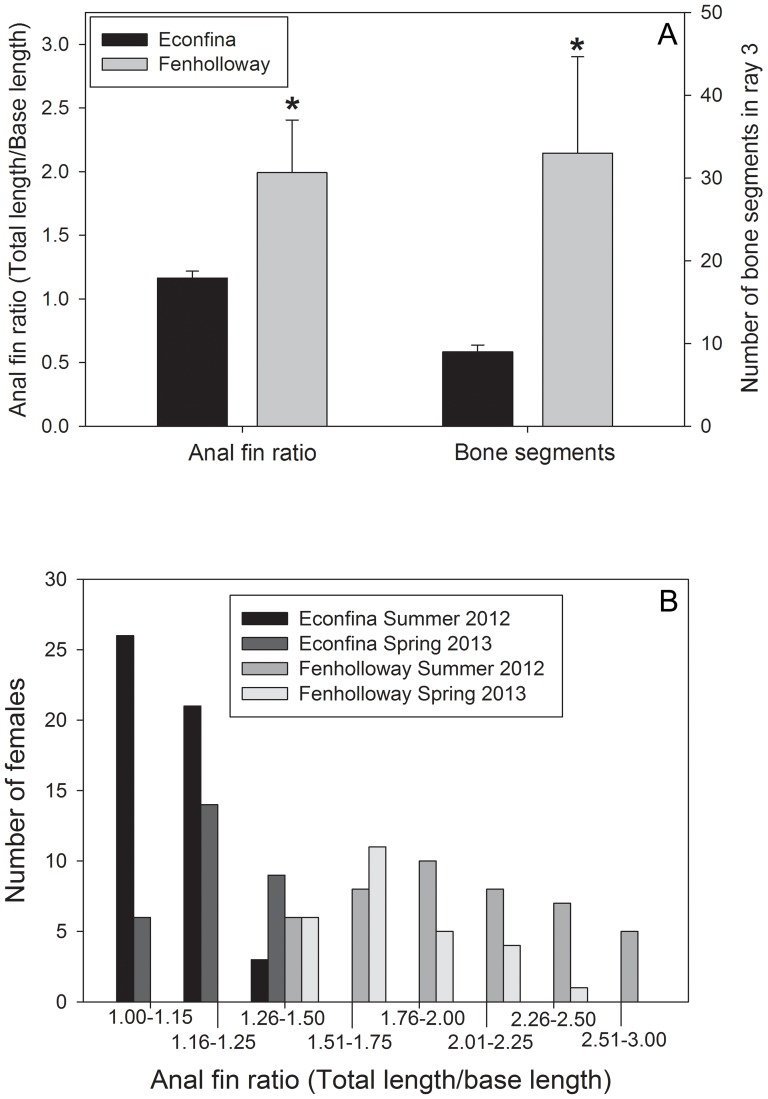
Anal fin elongation and bone segment formation in anal fin ray 3 of female Eastern mosquitofish (Gambusia holbrooki) collected from the Fenholloway and Econfina Rivers.Data are repsresented as (A) Mean (± standard deviation) of all collection events and, (B) Distribution of anal fin elongation classes between both paper mill exposed (Fenholloway) and reference (Econfina) field sites. An asterisk indicates statistical significance between the two groups as determined using a Student's t-test with p<0.05. For anal fin elongation levels there was an N of 46 and 50 from the Fenholloway and Econfina rivers respectively and a subset N of 4 from both sites for the bone segment evaluation.